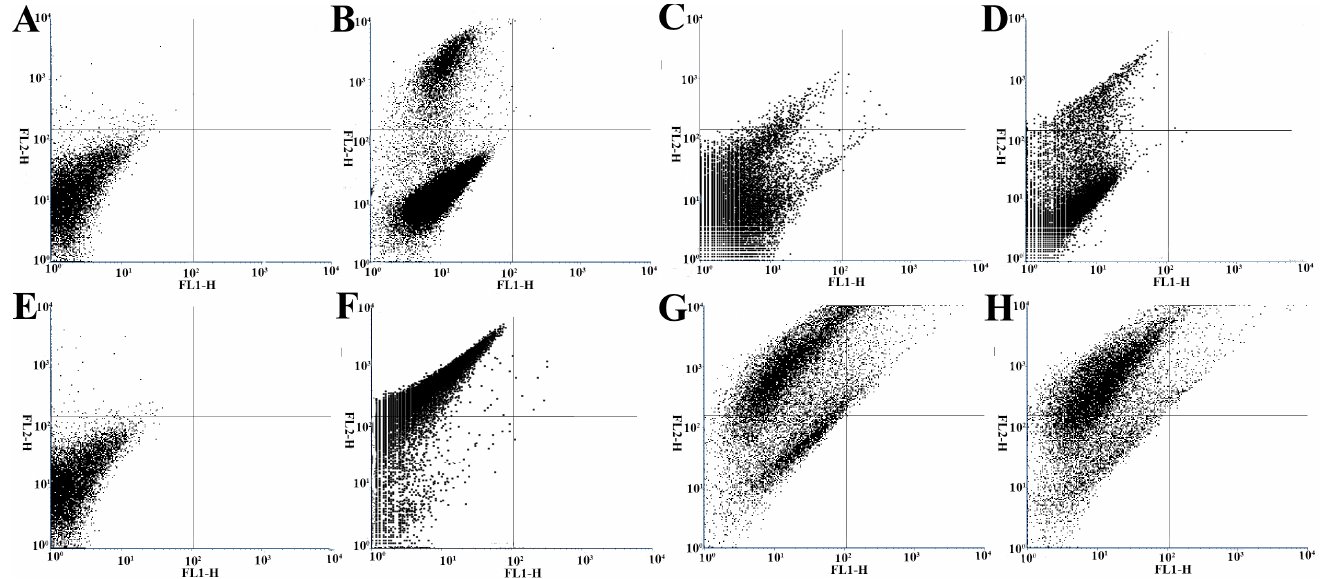
Figure 4. Flow cytometry images of Trichophyton rubrum conidia in different treatment groups at 8 h and 24 h post-treatment. ( A , E ) control; ( B , F ) MIC TB ; ( C , G ) MIC Neral ; ( D , H ) MIC Geranial . MIC, minimum inhibitory concentration.